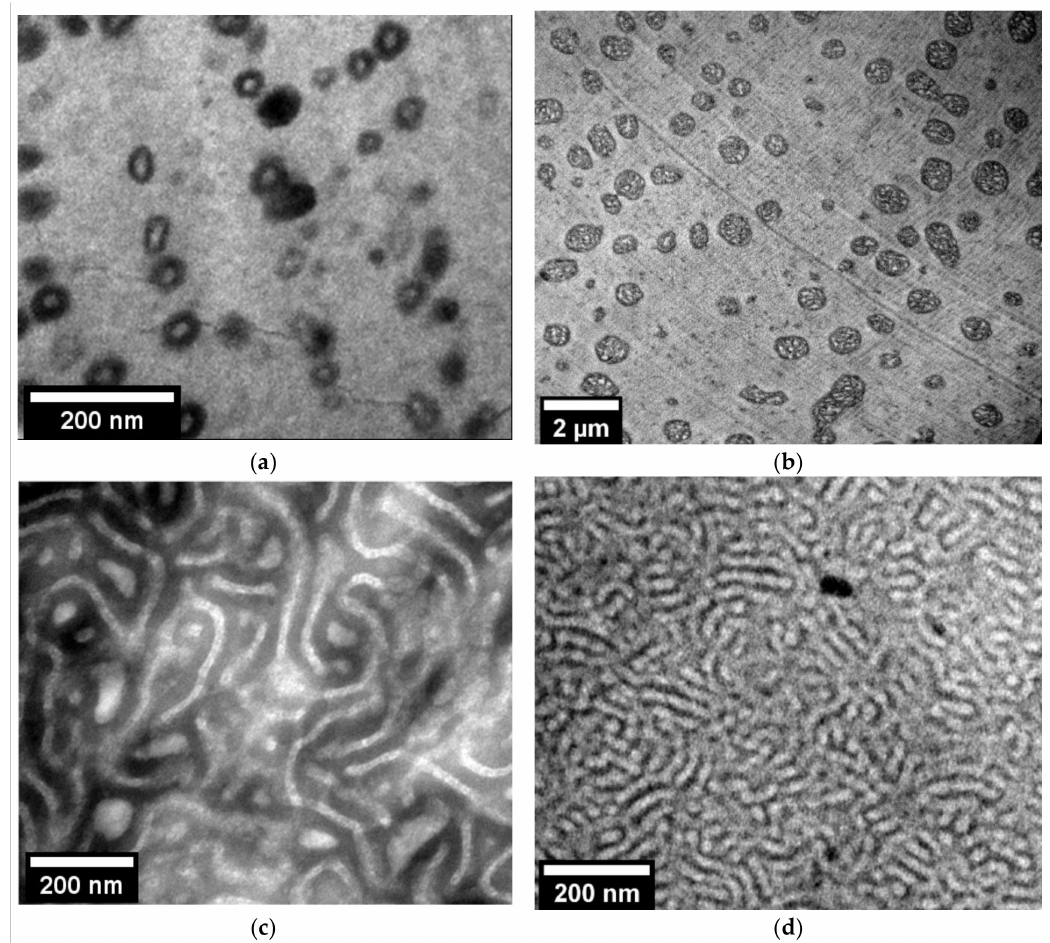
Figure 1. TEM micrographs of the nanostructuration of ( a ) 90/10 PMMA/MAM out-of-equilibrium blend (Reprinted from Chemical Engineering Journal, 243, J. Pinto, M. Dumon, M. Pedros, J. Reglero, M.A. Rodriguez-Perez, Nanocellular CO 2 foaming of PMMA assisted by block copolymer nanostructuration, Pages 428–435, Copyright (2014) [28], with permission from Elsevier); ( b ) 90/10 PMMA/MAM near-equilibrium blend, please notice the above one-order-of-magnitude difference between scales; ( c ) 25/75 PMMA/MAM out-of-equilibrium blend (Reprinted with permission from The Journal of Physical Chemistry C, 118, 9. Block Copolymers Self-Assembly Allows Obtaining Tunable Micro or Nanoporous Membranes or Depth Filters Based on PMMA; Fabrication Method and Nanostructures, J. Pinto, M. Dumon, M.A. Rodriguez-Perez, R. Garcia, C. Dietz, Pages 4656–4663. Copyright (2014) American Chemical Society) [29]; ( d ) 25/75 PMMA/MAM near-equilibrium